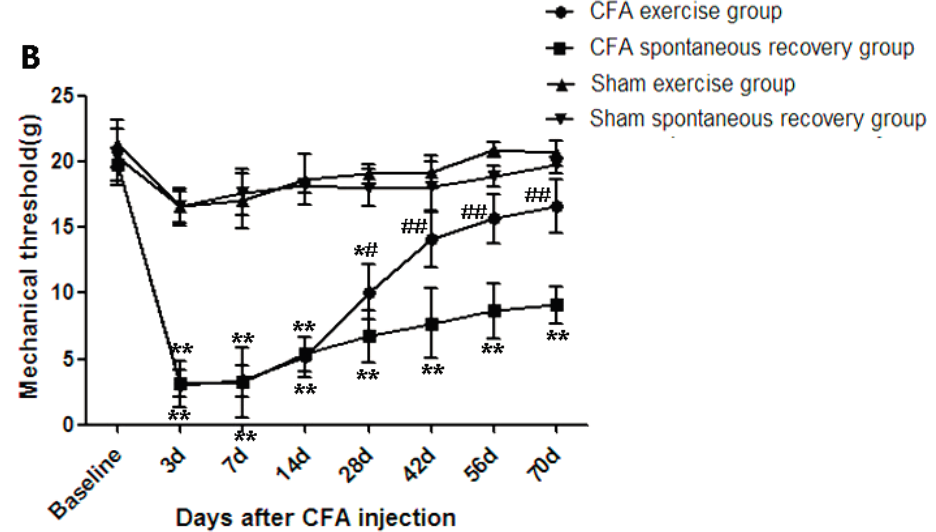
Figure 1. Running exercise significantly attenuated the bilateral hindpaw mechanical allodynia induced by complete Freund’s adjuvant (CFA). The intradiscal CFA injection induced significant decreases in the mechanical withdrawal thresholds of the left ( A ) and right ( B ) hindpaws in response to von Frey filaments ( p ˂ 0.01), however, no significant bilateral mechanical allodynia were observed in sham-operation groups (the sham exercise and the sham spontaneous recovery) compared to the baseline. For the CFA groups, the bilateral mechanical withdrawal thresholds were signi fi cantly increased in the exercise group compared to the spontaneous recovery group on day 28 ( p ˂ 0.05) and days 42, 56 and 70 ( p ˂ 0.01). The data are expressed as the mean ± SDs, n = 8 in each CFA groups, n = 5 in each sham-operation groups. Independent-samples t tests were used to examine the differences between the CFA running exercise subgroups vs. the CFA spontaneous recovery subgroups, and the sham exercise subgroups vs. the sham spontaneous recovery subgroups at the specific time points. We also used one-way analysis of variance